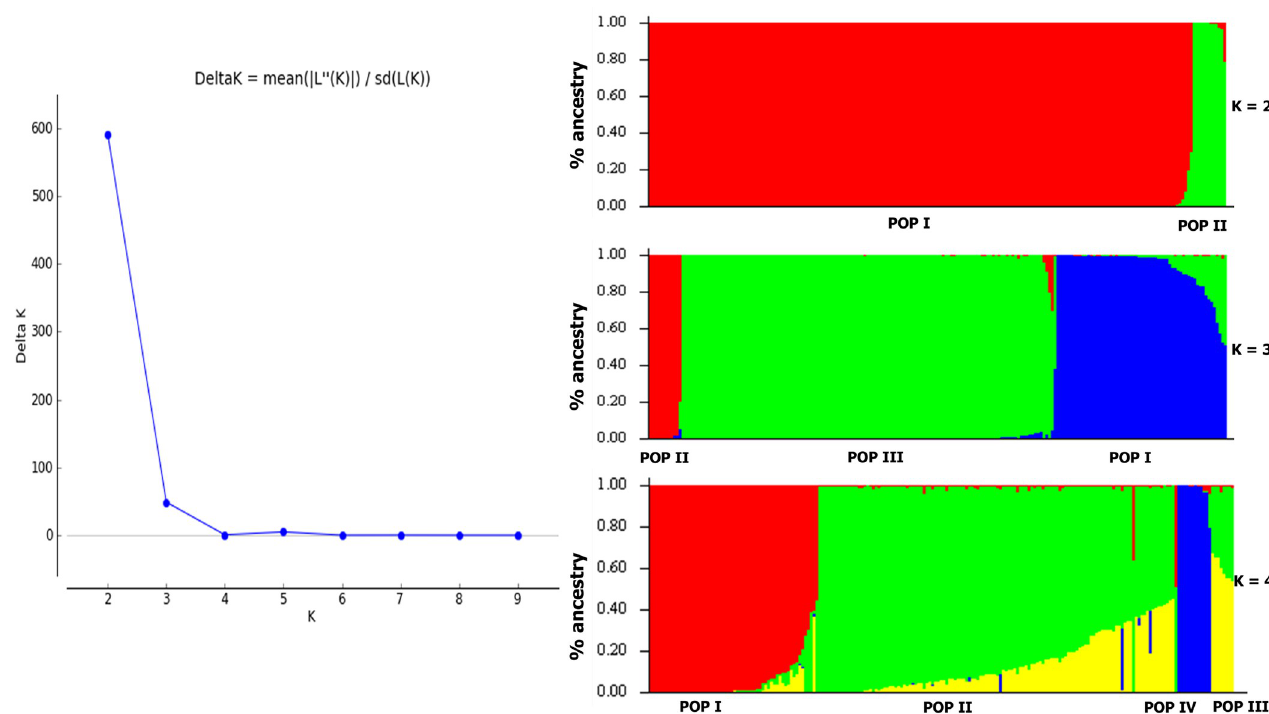
Fig 5. Population structure in the yam germplasm. (A) Likelihood of Δ K showing the best K value (K = 2); (B) Population structure obtained for 207 yam genotypes based on 4,957 SNPs.